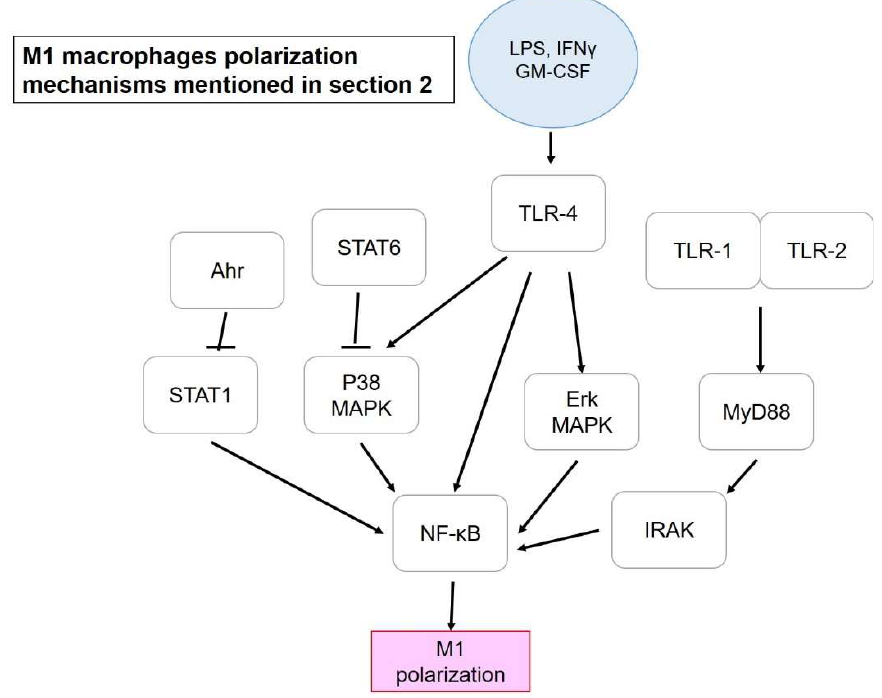
Figure 1. M1 macrophage polarization mechanisms mentioned in Section 2. Blue circle, inducers; white blocks, genes/proteins involved.